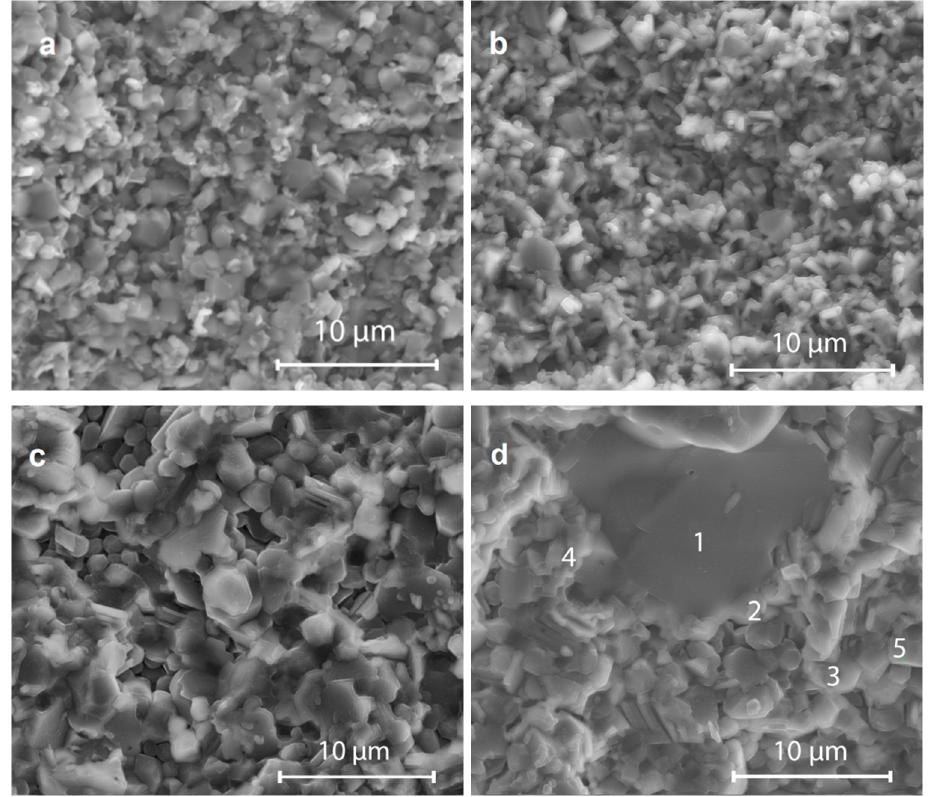
Figure 3. SEM images of fractured cross-sections of ceramic samples: ( a ) CuB 2 O 4 sintered at 940 °C, ( b ) Cu 3 B 2 O 6 sintered at 930 °C, ( c ) 50% CuB 2 O 4 –50% Cu 3 B 2 O 6 doped with 5% CuBi 2 O 4 sintered at 920 °C, and ( d ) 30% CuB 2 O 4 –70% Cu 3 B 2 O 6 doped with 5% CuBi 2 O 4 sintered at 900 °C, × 10000.